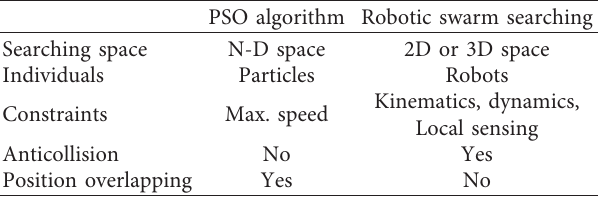
Table 1: Mapping PSO to robotic swarm searching tasks. PSO algorithm Robotic swarm